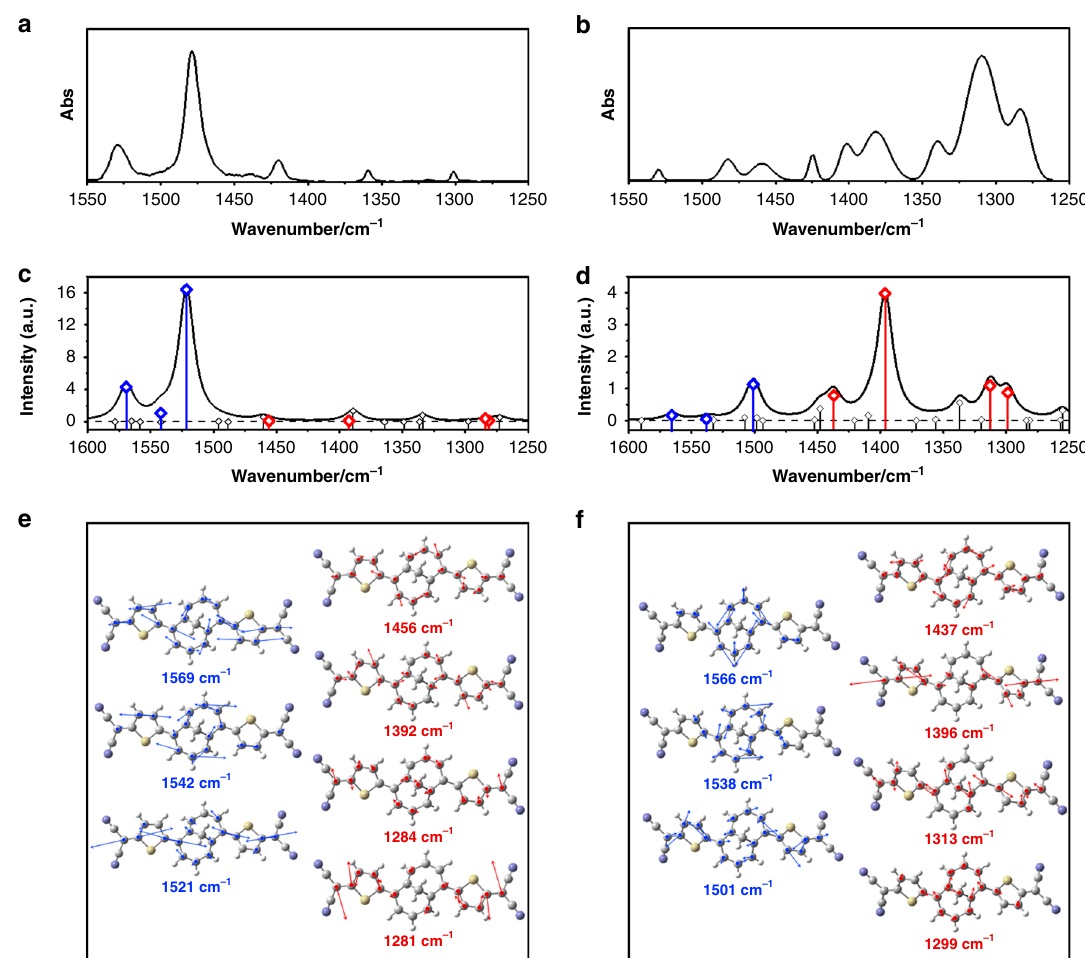
Fig. 3 Analyses of C = C stretching IR spectral features of TMTQ. a – d The experimental ground-state ( a ) and excited-state ( b ) IR spectra and calculated S 0 -state ( c ), and T 1 -state ( d ) IR spectra of TMTQ. In the calculated IR spectra, blue-colored vertical bars indicate the C = C stretching modes along the core annulene and red colored bars correspond to the C = C stretching vibrations over the long axis of TMTQ. e – f The C = C stretching vibrational motions of TMTQ in the S 0 ( e ) and T 1 states ( f ) are colored as blue and red, respectively, which are matched with the corresponding C = C stretching